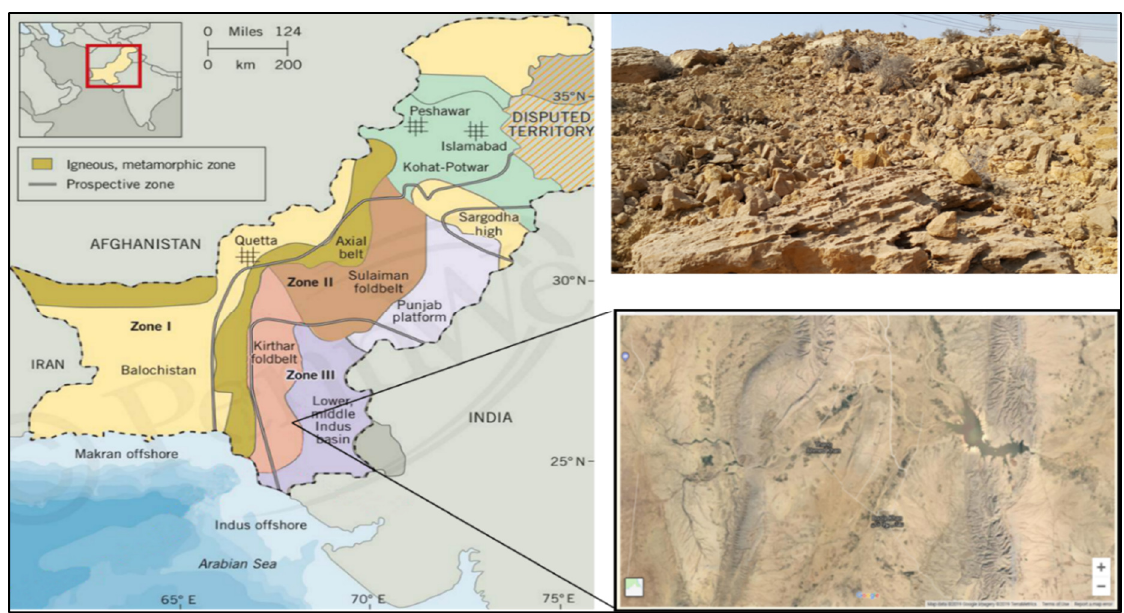
Fig. 1: The Study area exposed in between Thana Bola Khan and Thana Ahmed Khan north-east of Karachi Metropolis, The upper right photo is the image of field and the lower right is taken from Googlemaps tm , 2019 (Map Modified From Shar et al.